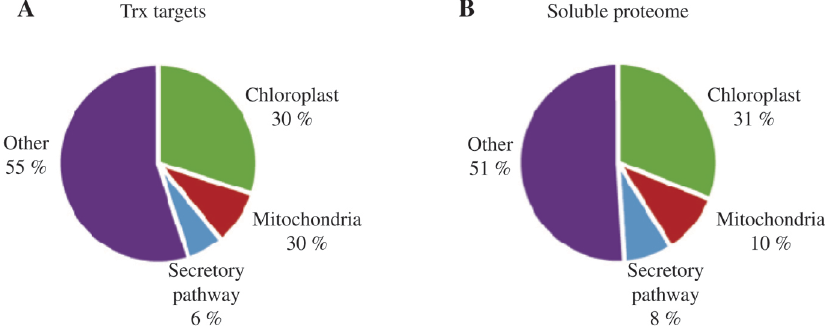
Figure 10: Subcellular localization of Chlamydomonas proteins. Pie charts of the subcellular localization of Trx-targets (A) are shown in comparison to proteins of the soluble proteome (B).